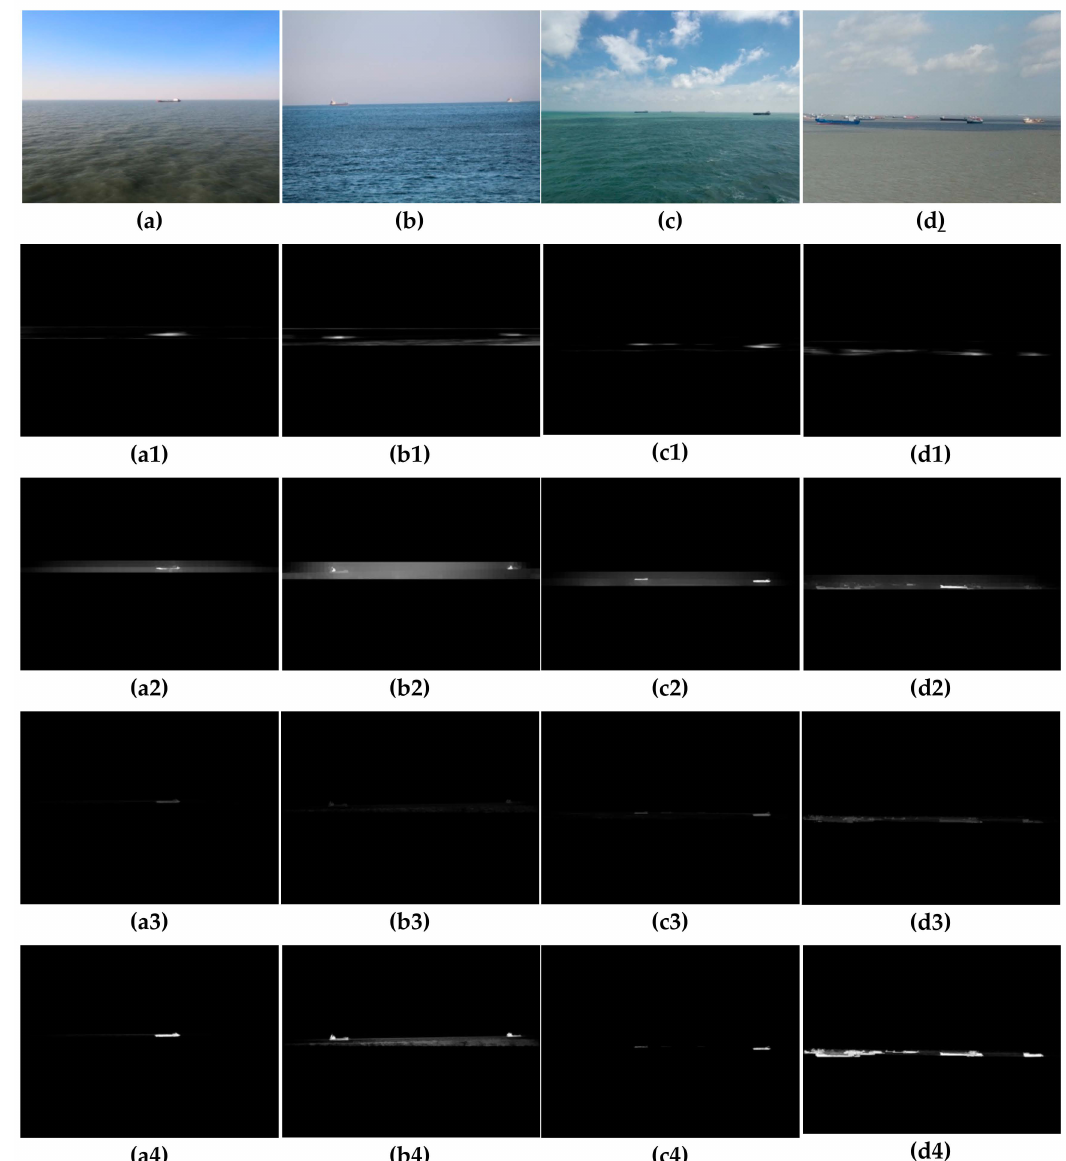
Figure 13. Saliency detection results by the four methods. ( a – d ) Original images. ( a1 – d1 ) Saliency detection results by SR. ( a2 – d2 ) Saliency detection results by RBD. ( a3 – d3 ) Saliency detection results by FMBD. ( a4 – d4 ) Saliency detection results by the proposed